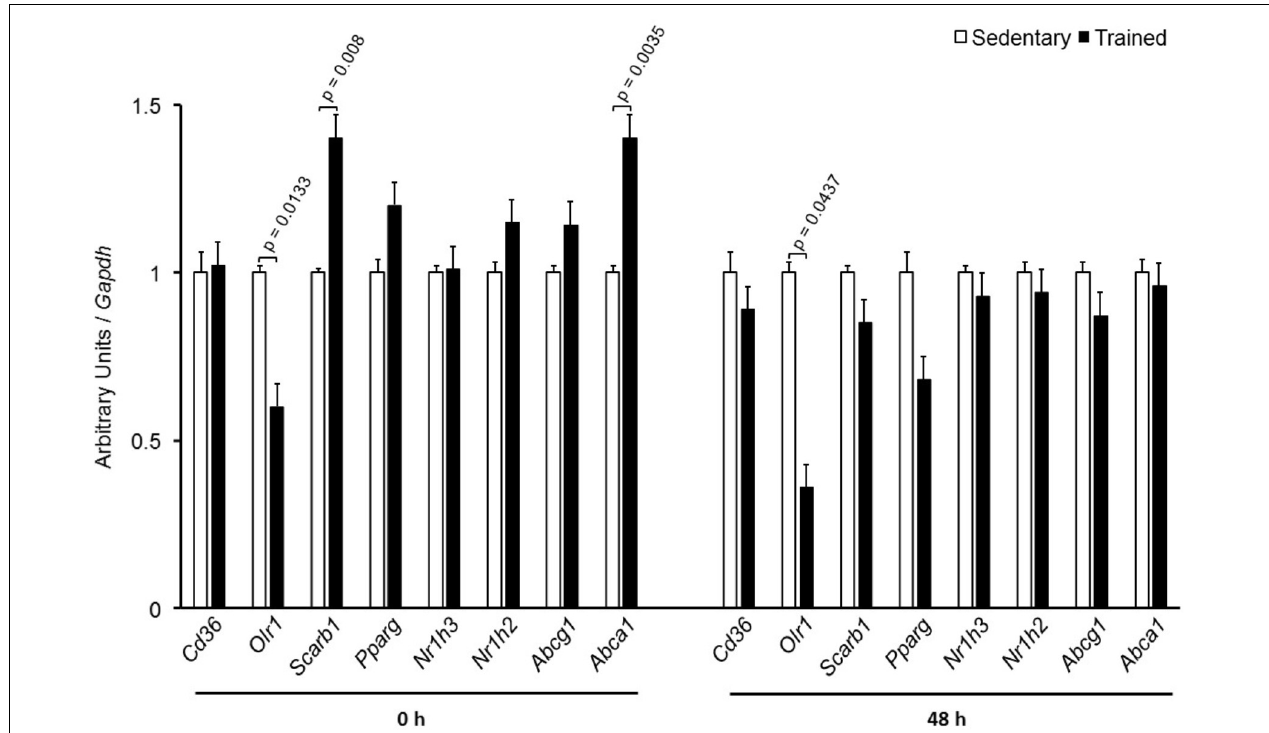
FIGURE 3 | Expression of genes related to lipid flux in the aortic arch of sedentary (S) and trained (T) mice. The aortic arch was removed from CETP-tg S ( n = 7) and T ( n = 6) mice immediately (0 h) or 48 h after the last session of exercise. The expression of genes was analyzed by RT-qPCR and expressed as arbitrary units corrected per Gapdh . Comparisons were done by the unpaired Student t -test (mean ±